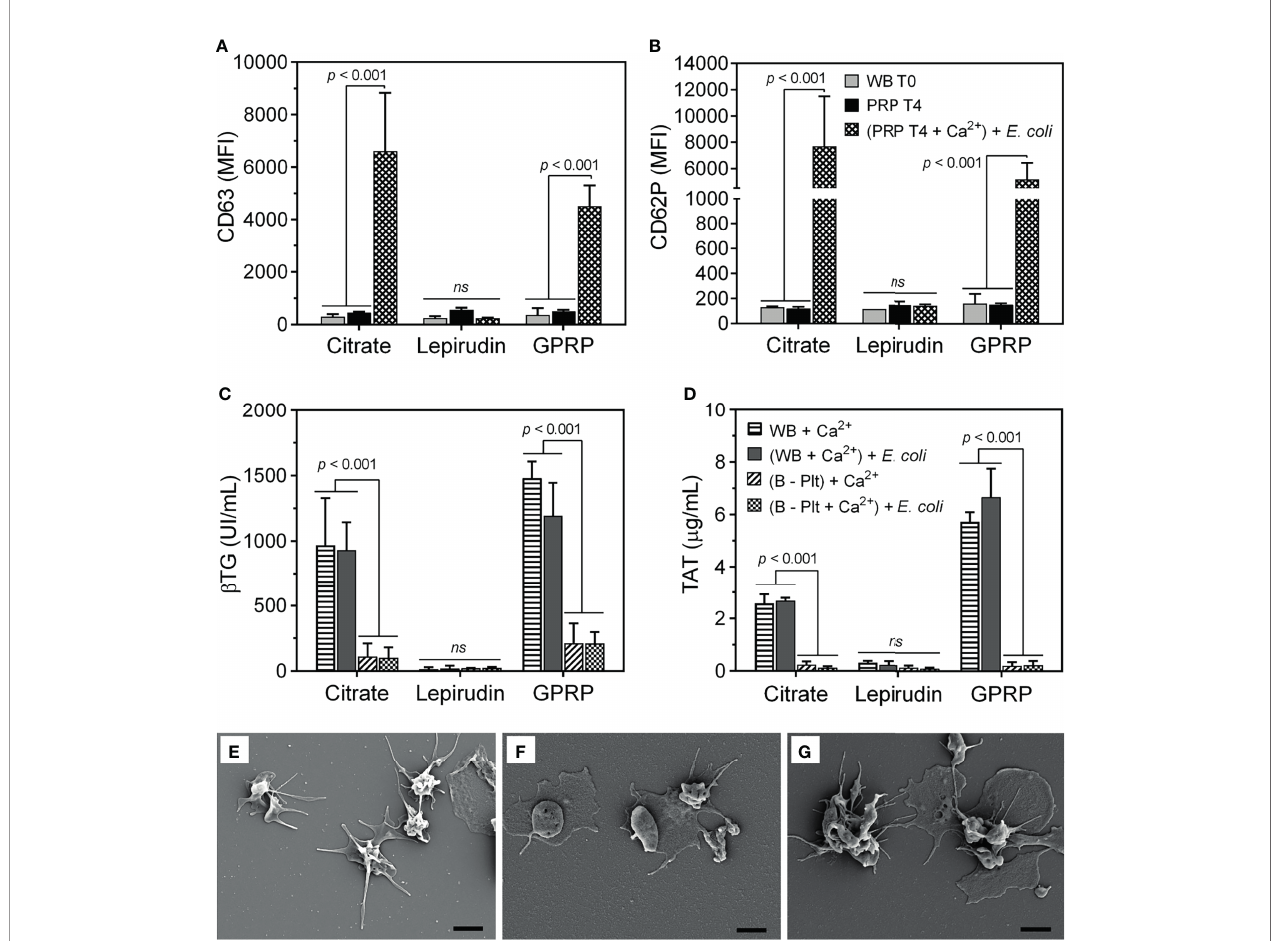
FIGURE 2 | Evaluation of platelet activation during the platelet separation process. The activation of platelets was evaluated by the expression of (A) CD63 and (B) CD62P on the platelet surface using fl ow cytometry. The expression of CD63 and CD62P was measured in whole blood immediately after collection (indicated as “ WB T0 ” ) and in platelet-rich plasma (PRP) 4 hours after platelet isolation (indicated as “ PRP T4 ” ). In addition, 4 hours after platelet separation, platelet activation was induced by incubation with E . coli (10 7 /ml, indicated as “ (PRP T4 + Ca 2+ ) + E . coli ” after re-calci fi cation. Data are presented as mean of median fl uorescence intensity (MFI) ± standard deviation (SD) (n = 9). (A, B) have the same annotation as shown in (B) . In addition, platelet activation was evaluated by its soluble activation marker (C) b -thromboglobulin ( b TG) and thrombin generation by (D) thrombin-antithrombin complex (TAT) in plasma from whole blood after blood sampling (WB + Ca 2+ ) and whole blood after platelet-depletion [(B - Plt) + Ca 2+ ], or after incubation with E . coli for 15 minutes, indicated as “ (WB + Ca 2+ ) + E . coli ” and “ (B - Plt + Ca 2+ ) + E. coli ” , respectively. Data are represented as mean ± standard deviation (SD) (n = 6). (C, D) have the same annotation as shown in (D) . Platelet activation was further evaluated with scanning electron microscopy, as presented in an image representative of 6-9 samples collected (E – G) . Platelets were collected in plasma-rich plasma (PRP) from whole blood anticoagulated with 3.2% (w/v) citrate (E) , lepirudin (50 m g/ml) supplemented with 0.7% (w/v) citrate (F) , and GPRP (8 mg/ml) supplemented with 0.7% (w/v) citrate (G) . Thrombin was used as a platelet activator. The scale bar at the lower right represents 2 m m. ns, non signi fi